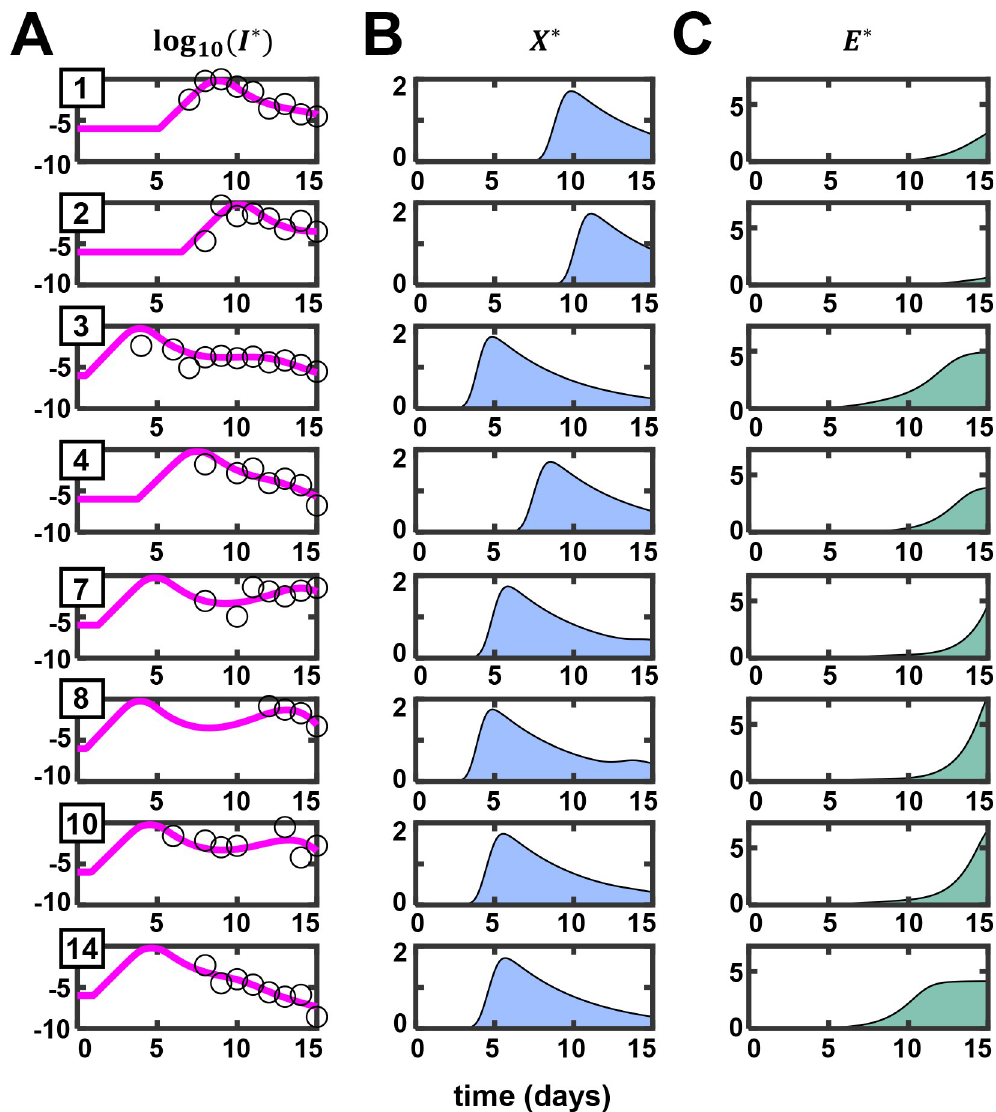
Fig 2. Model predictions are consistent with in vivo dynamics. (A) Best-fits of our model (lines) to patient data (symbols) of normalized sputum viral load as a function of time from viral exposure [38]. The corresponding (B) innate immune responses and (C) CD8 T-cell responses predicted by our model. The asterisks represent rescaled variables (see Methods). Patient IDs, as provided in Bo¨hmer et al. [37], are in the top-left corner of each subplot in (A).